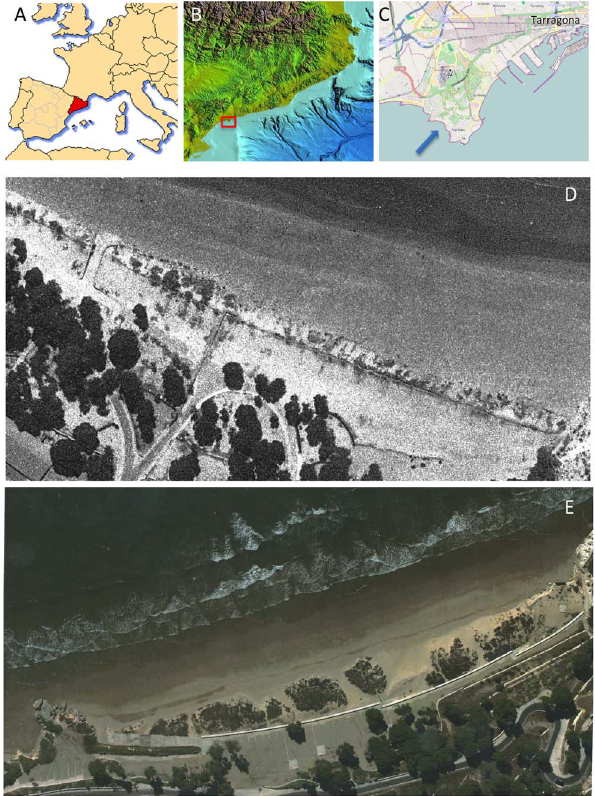
Figure 1. The study area. (a) A location map of the Catalonia Province; (b) A physiographic map of the Catalonia Province (non- copyrighted map, courtesy of Marine Geosciences Group, University of Barcelona); (c) A close-up map of the Llarga Beach (indicated with a blue arrow) and adjacent areas (image generated from an open access website: http://www.openstreetmap.org/); (d) an aerial photograph of Llarga Beach (flight # 10173, March 1, 1976; (cid:2) Cartographic Institute of Catalonia; reproduced with permission of the Cartographic Institute of Catalonia); (e) an aerial photograph of Llarga Beach (flight # 2011072000290012, February 18, 2011; (cid:2) Cartographic Institute of Catalonia; reproduced with permission of the Cartographic Institute of